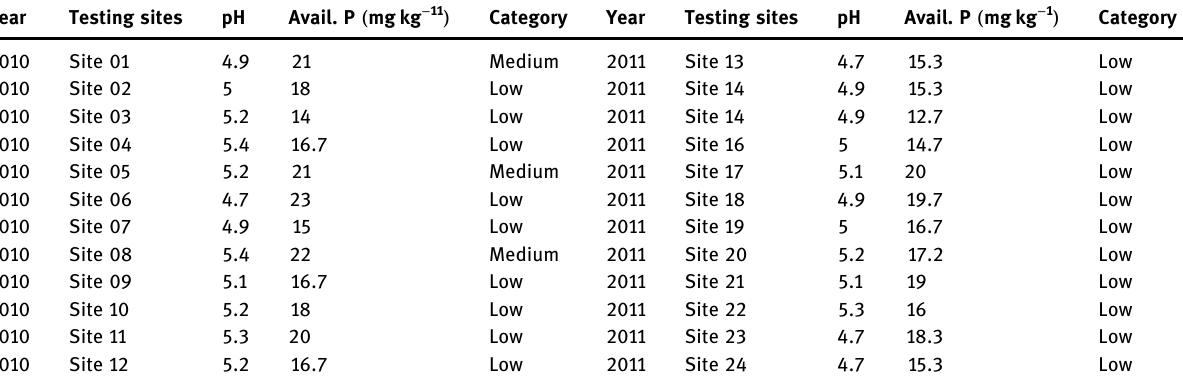
Table 1: Initial soil phosphorous statuses of the soil according to Mehlic method for sites selected at Lemu – Bilbilo district of Arsi zone